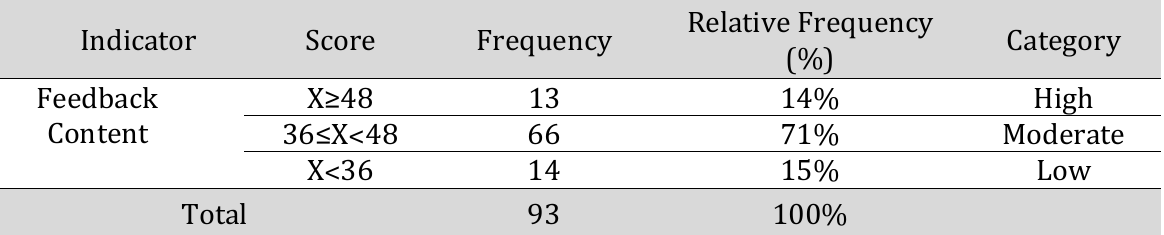
Table 11. Categorization of the teacher's oral feedback (indicator of feedback